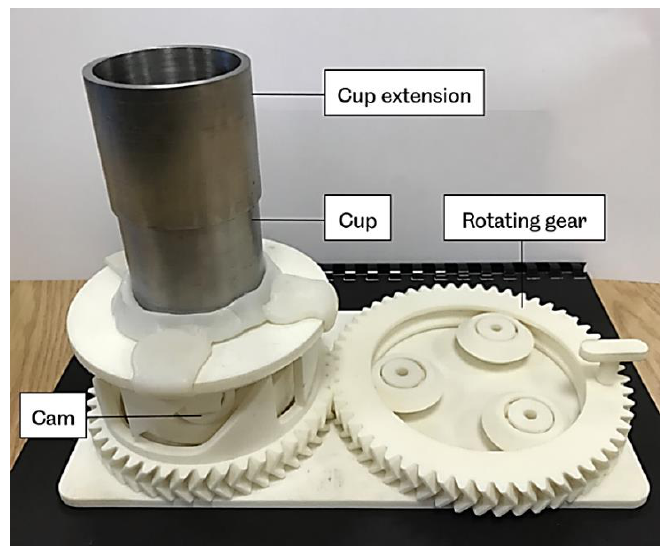
Figure 3. Tapped density measurement set-up.